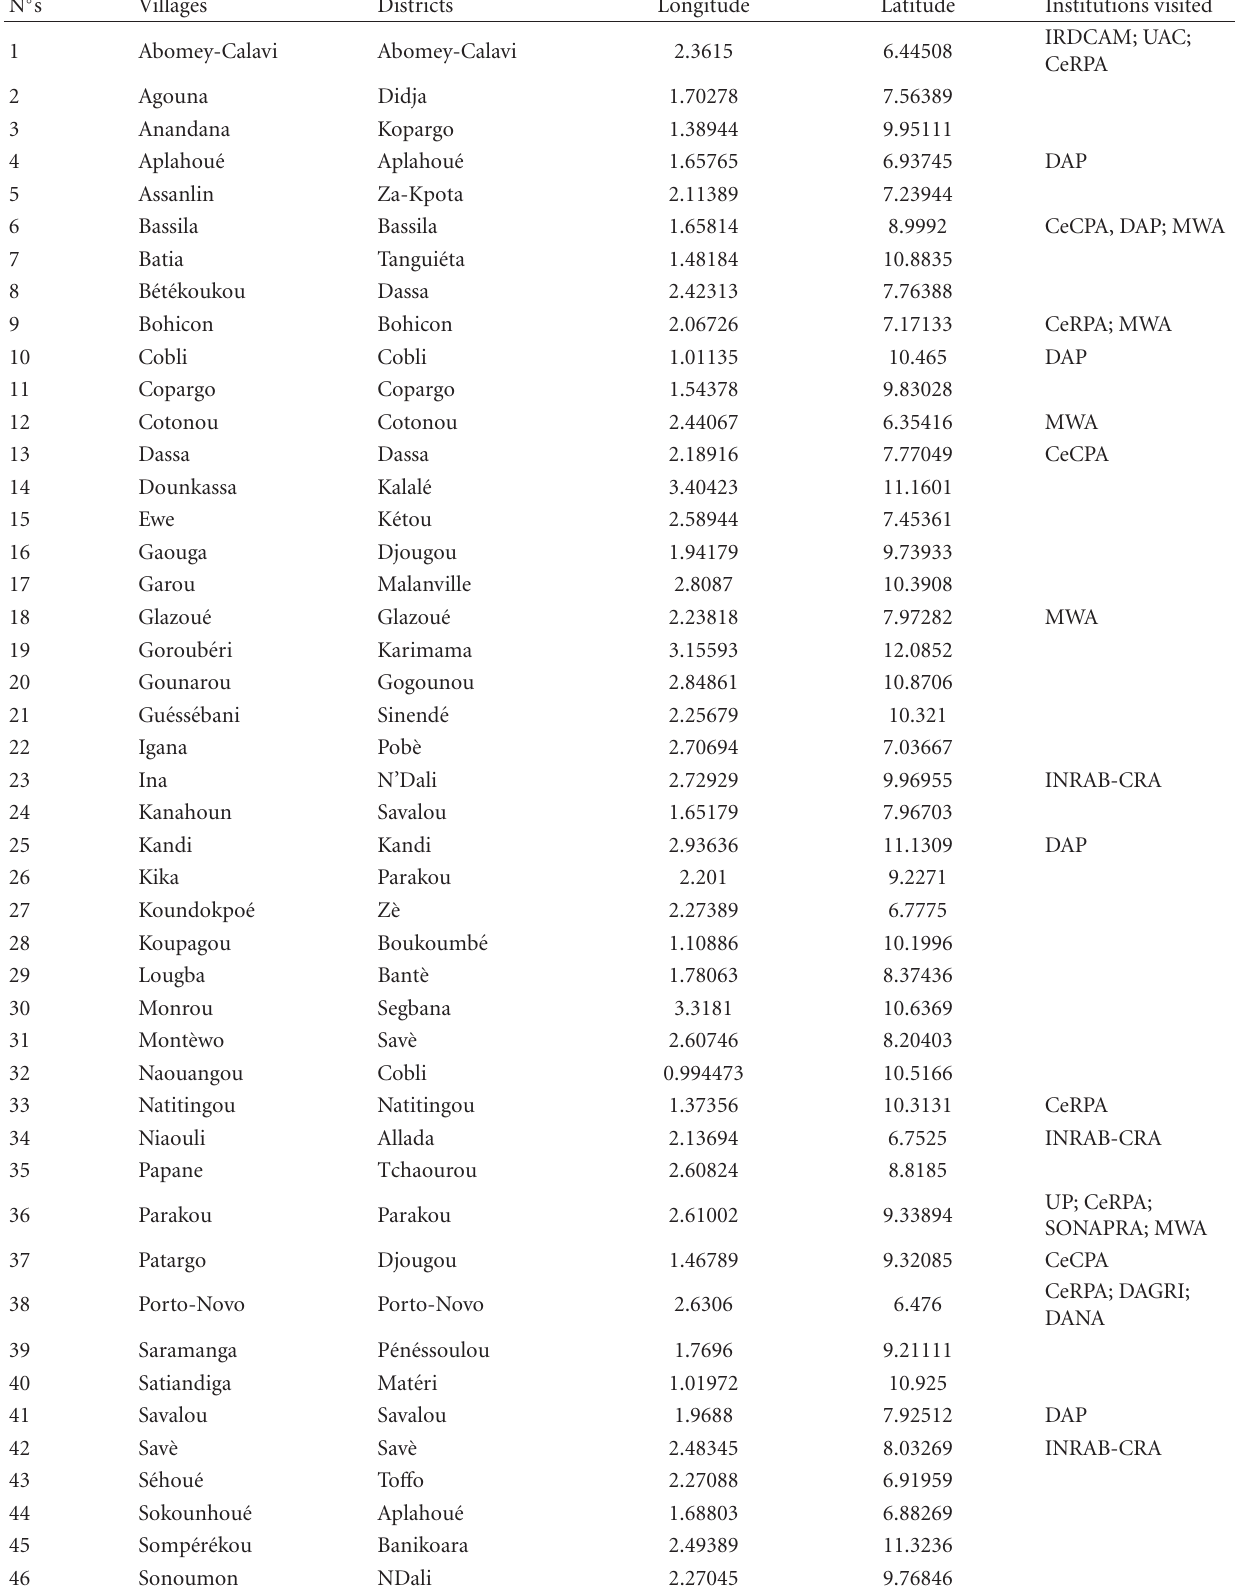
Table 1: List of the villages and institutions visited and their geographical